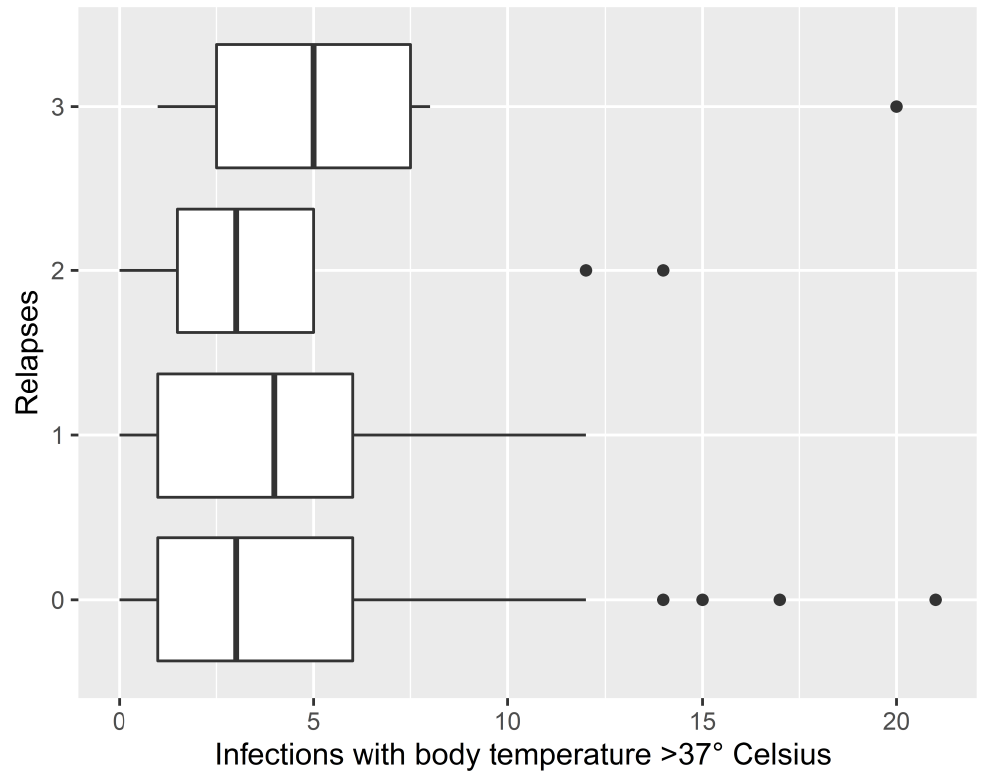
Figure 3. Correlation between the total number of infections with body temperature > 37° Celsius and the total number of relapses by patients.